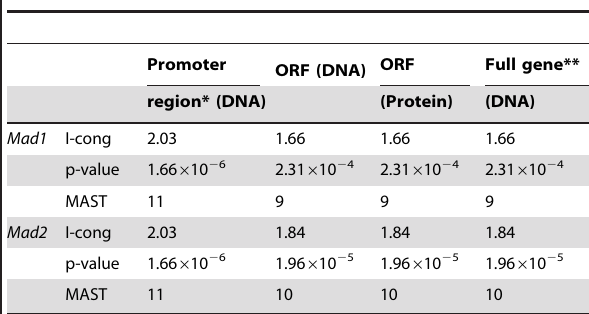
Table 1. Congruency values for pairwise comparisons of Mad1 and Mad2 phylogenetic trees to the 5 9 EF-1 a phylogenetic tree.